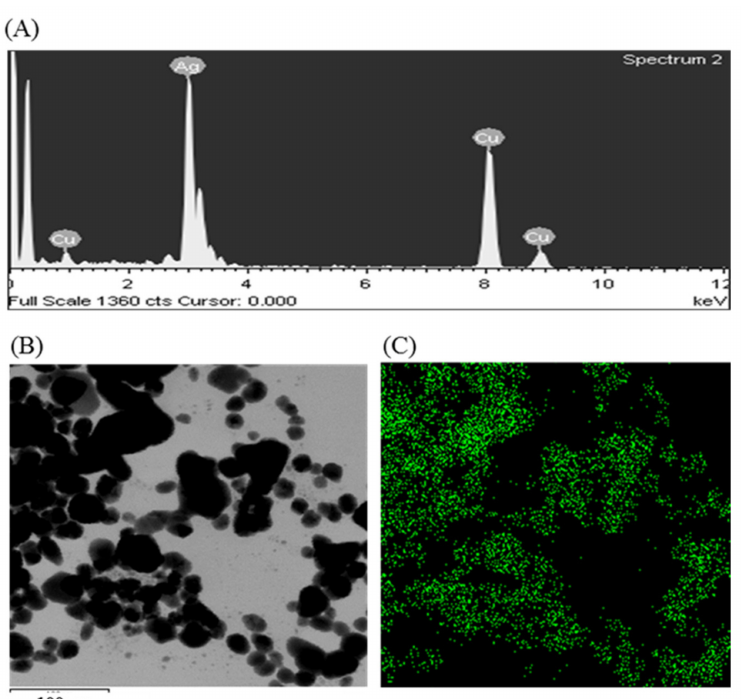
Figure 3. EDX spectrum P. nicotinovorans MAHUQ-43-mediated synthesized AgNPs ( A ), TEM image used for mapping ( B ) and distribution of silver in elemental mapping ( C ).